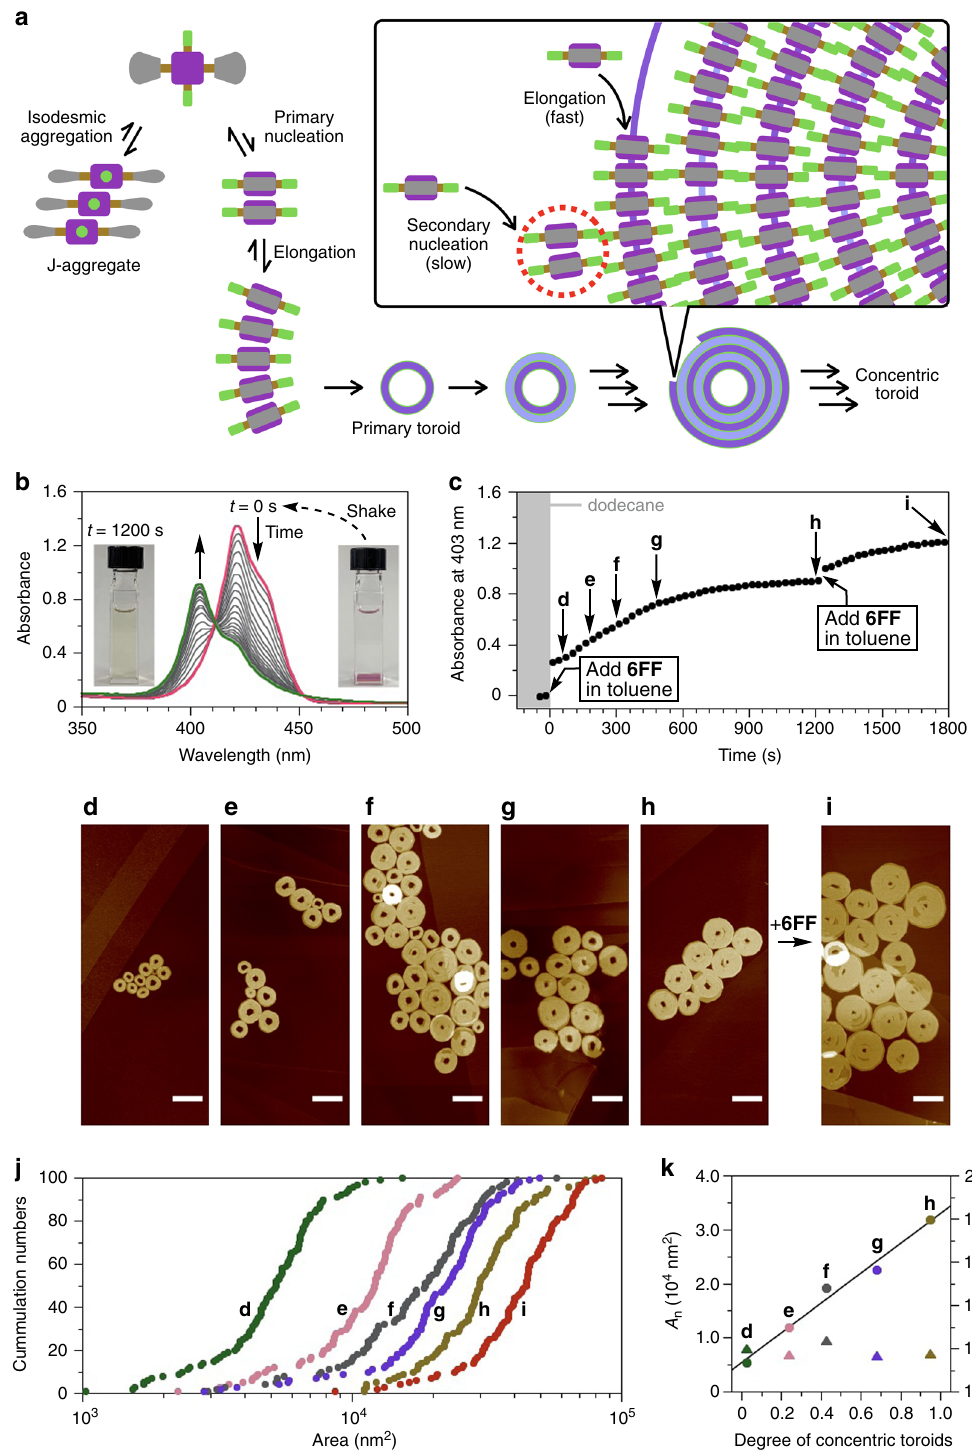
Fig. 6 Controlled synthesis of concentric toroids. a Schematic illustration of the formation of the concentric toroids. It is noteworthy that new toroids are formed not only at the outer circumference but also at the inner circumference of the primary toroid, as suggested by the decrease in size of the hole observed in the AFM images. b Time-dependent absorption spectral changes observed on mixing a toluene solution of 6FF with dodecane. [ 6FF ] = 5 μ M, toluene – dodecane = 1:19 (v/v), 298 K. c Plot of the absorbances at 403 nm as functions of time. d – i AFM images of concentric toroids obtained during the time-dependent evolution at d 60 s, e 180 s, f 300 s, g 480 s, h 1200 s, and i 1800 s (i.e., after the incremental addition of a 6FF solution). Scale bar = 200 nm. j Cumulative histograms of the area of concentric toroids obtained after the fi rst d – h and the second addition i of a toluene solution of 6FF to dodecane. The data were collected by tracing 100 objects in AFM images. k Plots of A n (circle) and Đ ( A w / A n , triangle) of the concentric toroids as a function of the degree of the concentric toroids d – h